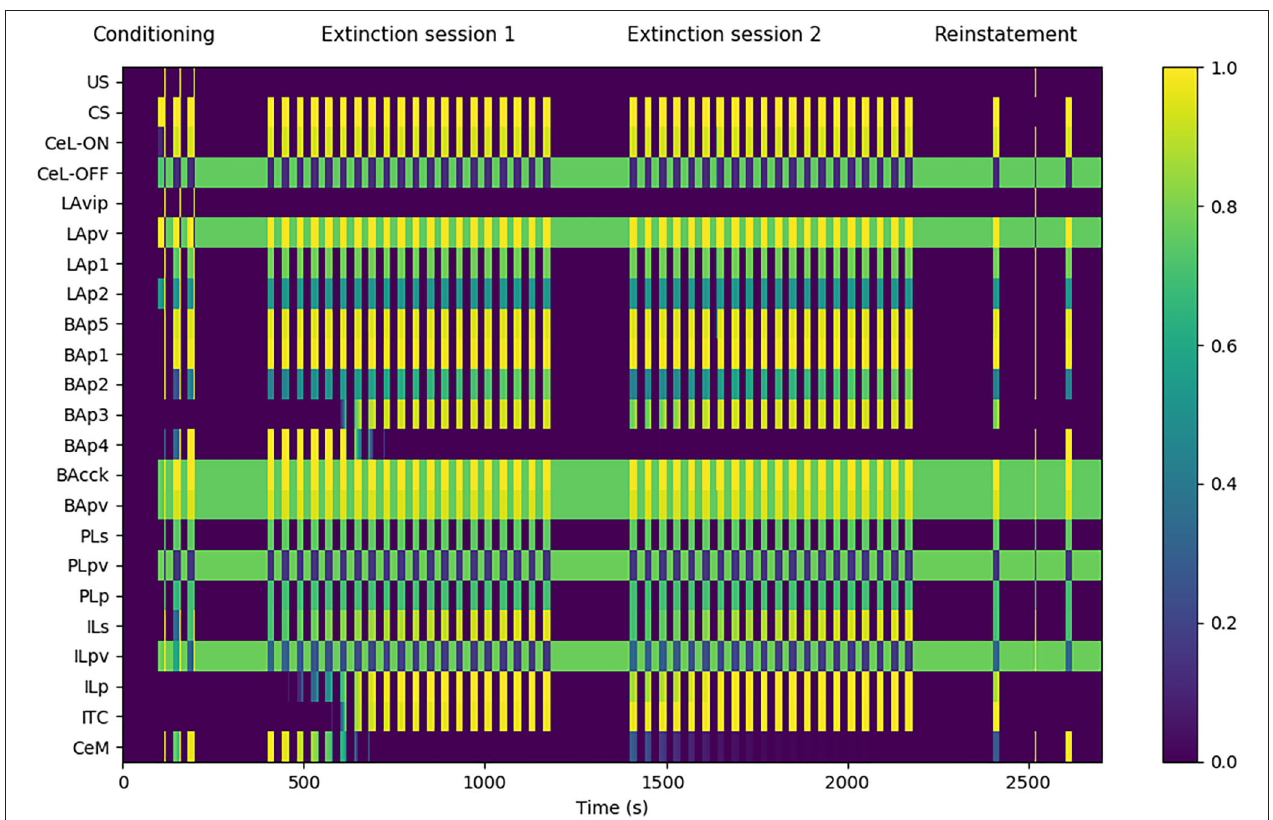
FIGURE 3 | Model functioning during the tests. The graph shows in particular the activation of the model units, indicated in the y-axis, during a session of fear conditioning, formed by: 3 CS stimuli paired with a short US; two sessions of extinction, consisting in 20 CS stimuli each; and a session of fear reinstatement, involving a sequence of “CS, US, CS” stimuli. The x-axis represents the time of the sessions. The activation of CeM represents the expression of freezing.